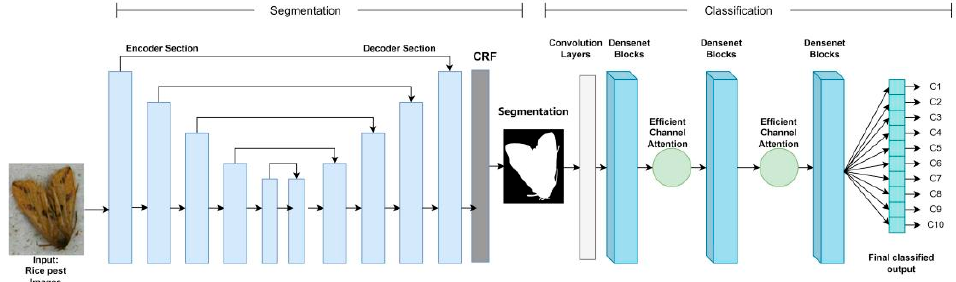
Figure 3. Schematic diagram of the proposed deep learning framework for image segmentation and classification of rice pests.